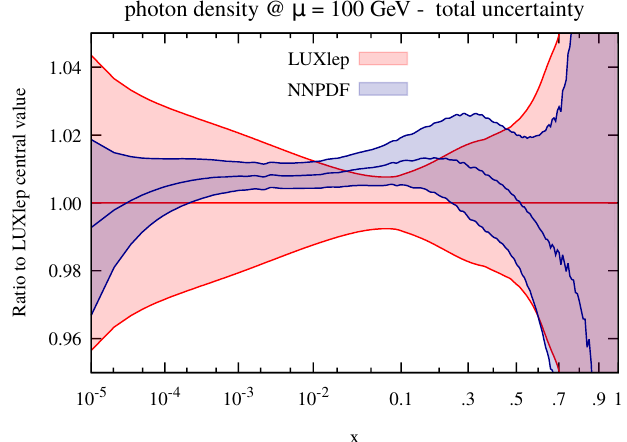
Figure 5. The full uncertainty band of the photon density in the LUXlep and in the NNPDF sets, normalized to the central value of LUXlep . The uncertainty band is obtained with the standard procedure that is adopted with